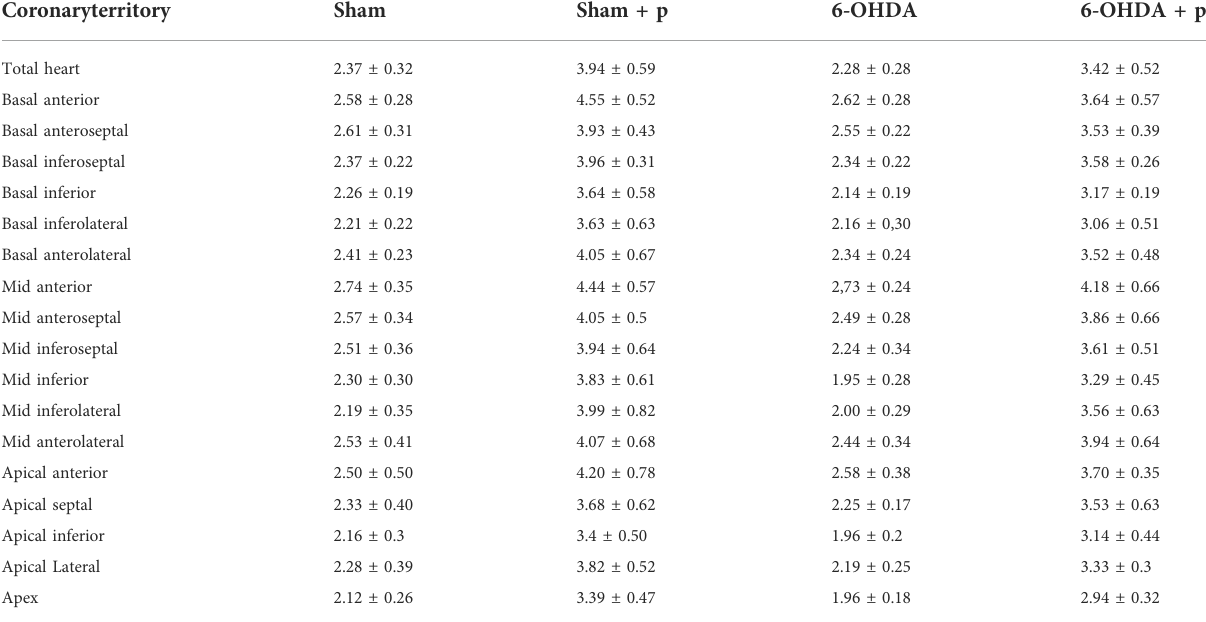
TABLE 1 Median data and con fi dence interval of [18F]FDG uptake value in different areas of the left ventricle. Coronaryterritory